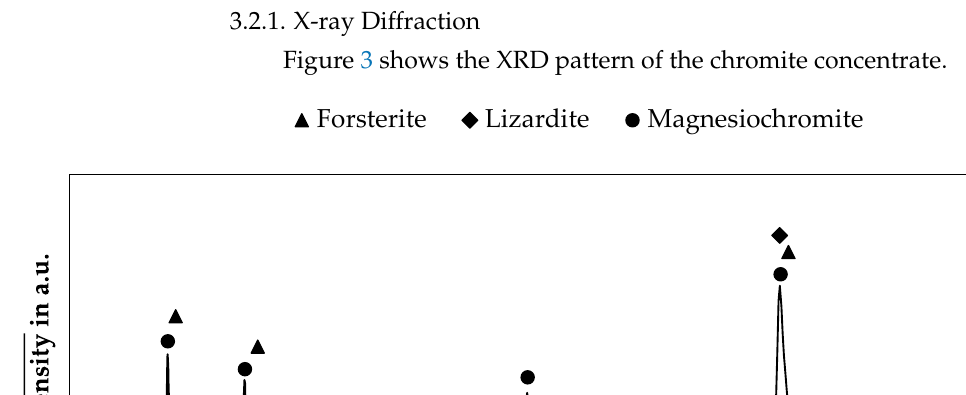
Figure 2. Carbon and sulfur content of chromite concentrate.